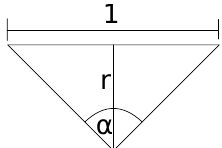
Figure 4: Sketch of the calculation of r .